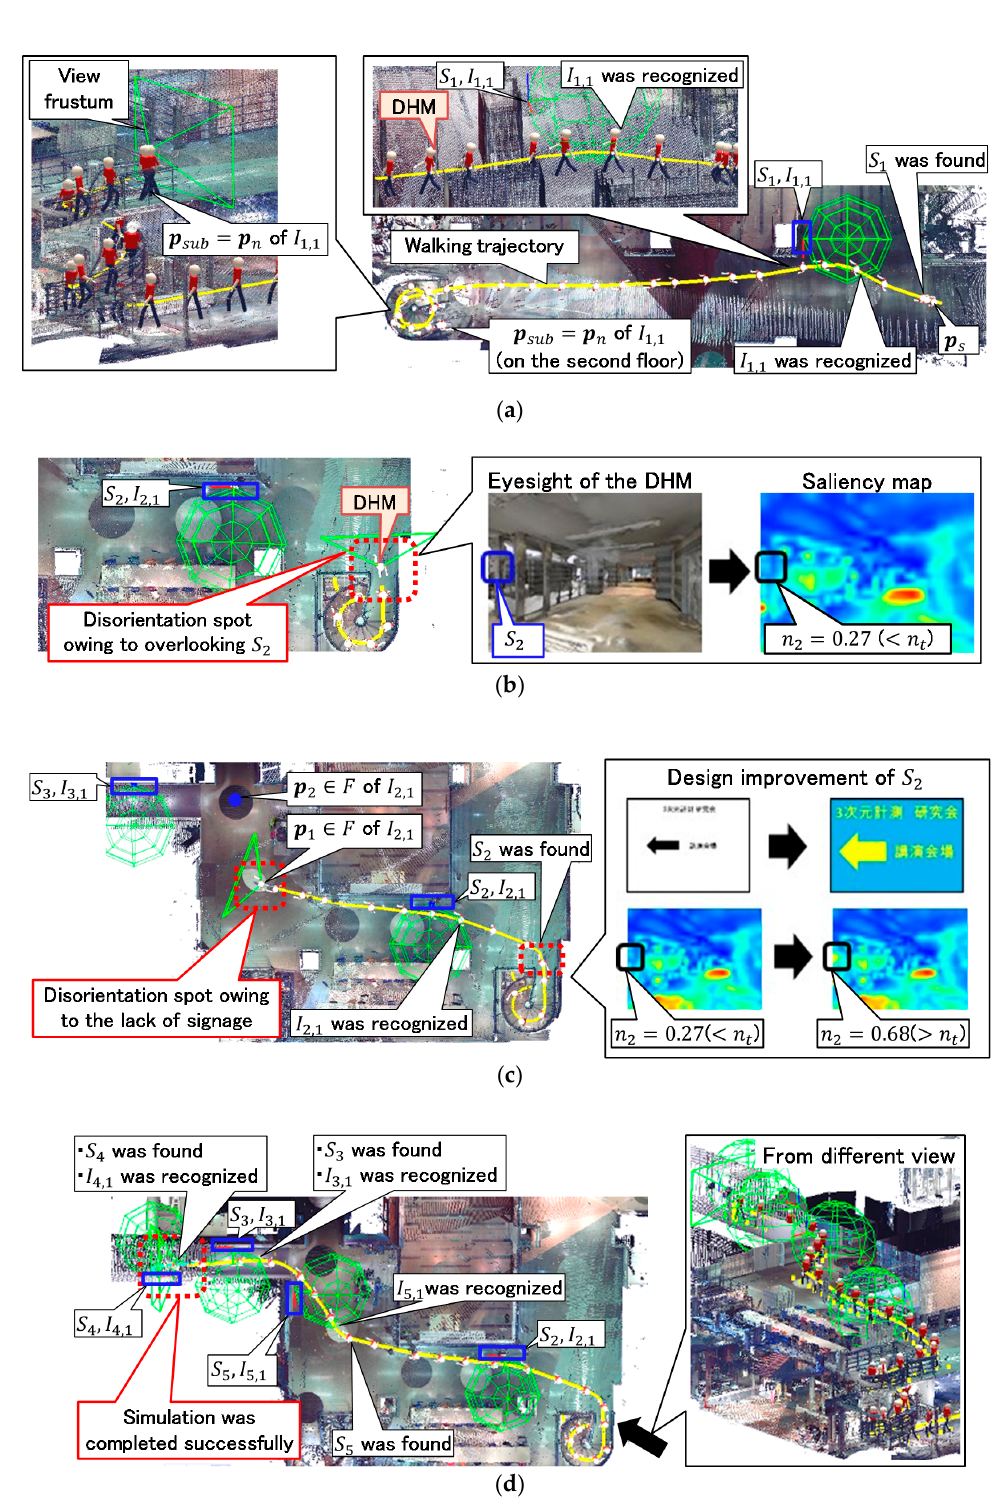
Figure 13. Evaluation results of ease of wayfinding in two-story indoor environment (yellow lines: walking trajectory of DHM): ( a ) Wayfinding simulation on first floor; ( b ) detection of disorientation spot resulting from overlooking the signage S 2 ; ( c ) design improvement of S 2 and detection of disorientation spot resulting from lack of signage; ( d ) ease of wayfinding improved completely by changing the design of S 2 and adding S 5 . The results are available in the supplementary video